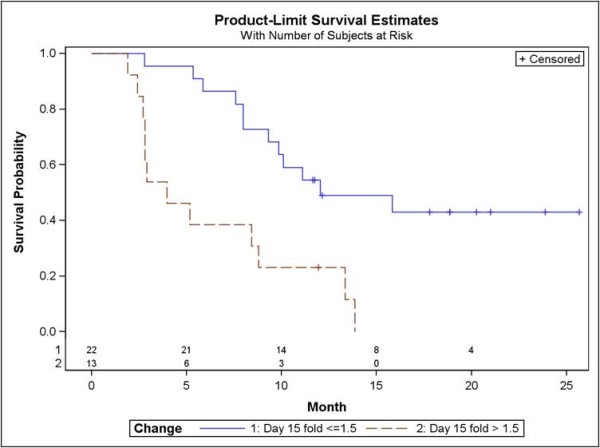
Progression-free-survival in metastatic renal cell carcinoma patients according to fold-increase in plasma NT-pro-BNP after two weeks of sunitinib treatment. Median PFS was 12.0 months in patients with less than 1.5 fold increases or lower or equal to baseline NT-pro-BNP levels (n = 22) and 3.9 months in patients with more than 1.5 fold increases in plasma NT-pro-BNP (n = 13) (log-rank test, p = 0.001).